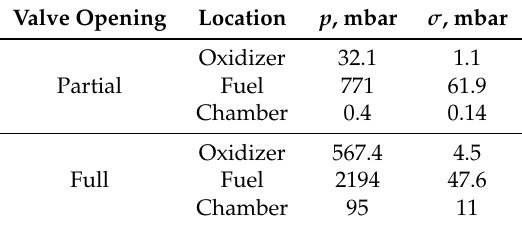
Table 3. Pressure variation during the ignition process.